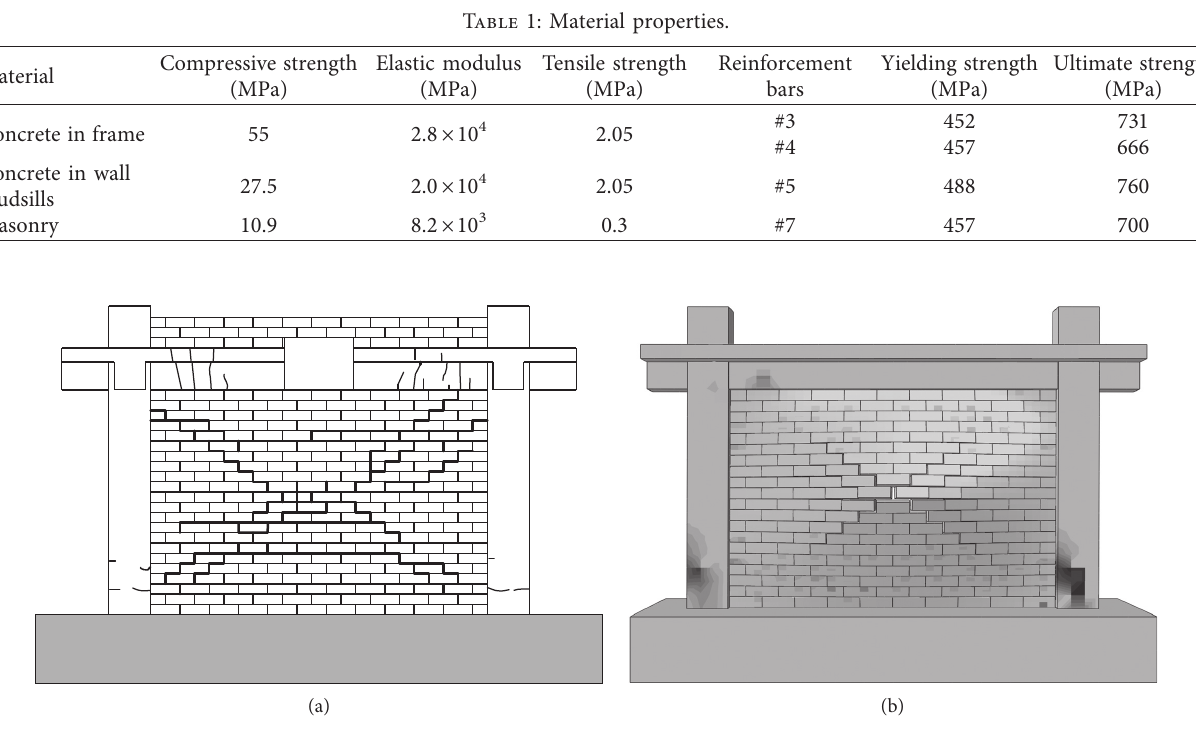
Figure 3: Damage patterns for (a) experimental and (b) numerical